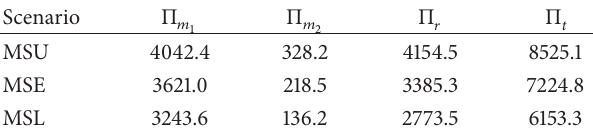
Table 4: The maximal profits in different